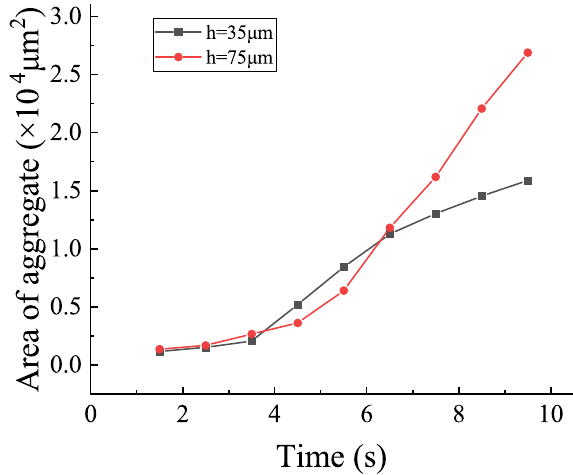
Figure 4. Areas of AP aggregates as a function of illumination time. P = 30 mW.